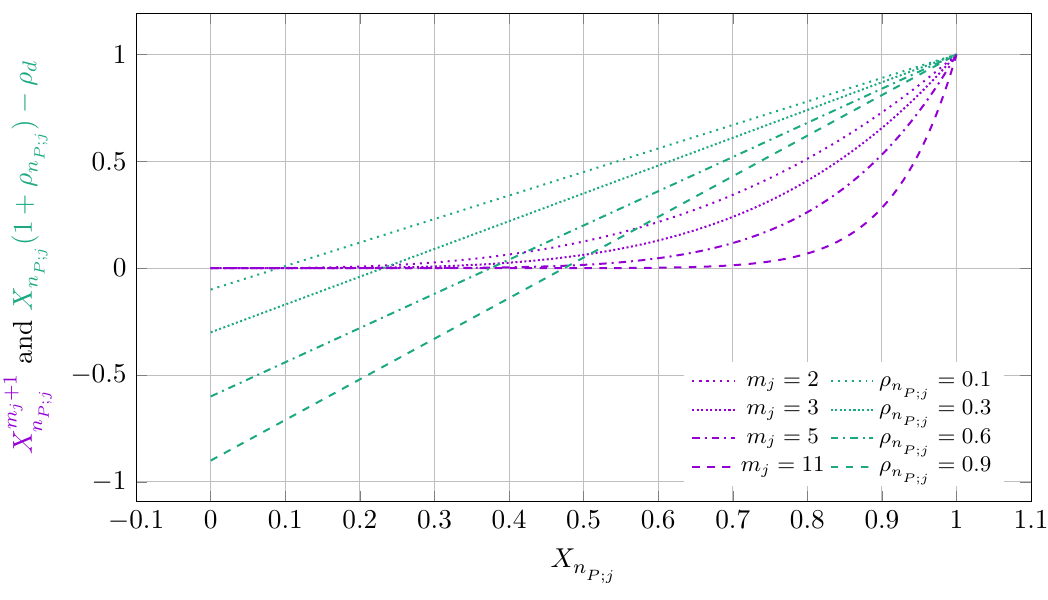
values at n P ; j